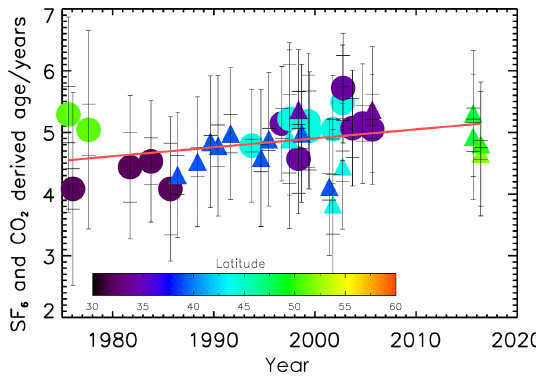
Figure 12. Time series of mean age derived from balloon obser- vations. The data prior to 2010 are those presented in Engel et al. (2009). The data from 2015 and 2016 are derived from the Air- Core measurements presented here. Each data point represents the average value of mean age derived above 30 and up to 5hPa. The inner error bars represent the variability (error of the mean), and the larger outer error bars include the uncertainty as discussed in En- gel et al. (2009). A non-significant trend of 0.15 ( ± 0.18) years per decade is derived from these